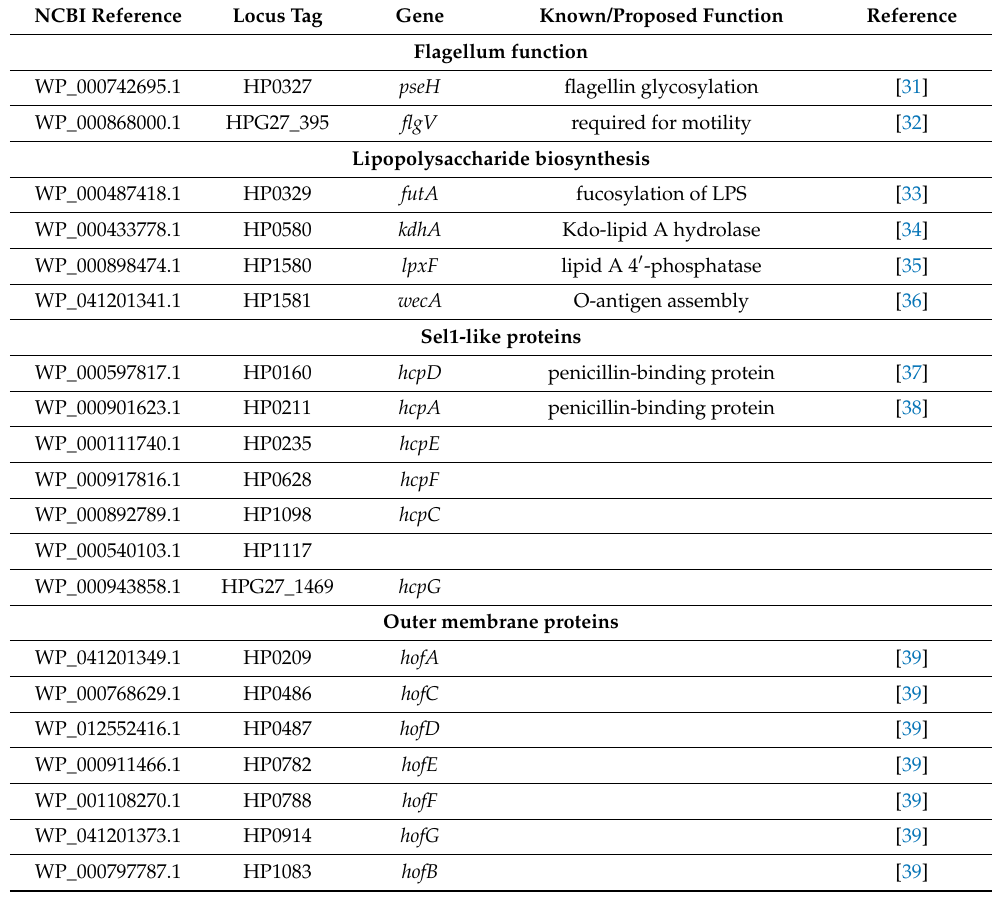
Table 1. Proteins conserved in Helicobacter species that have flagellar sheaths and underrepresented in Helicobacter species that have unsheathed flagella. NCBI